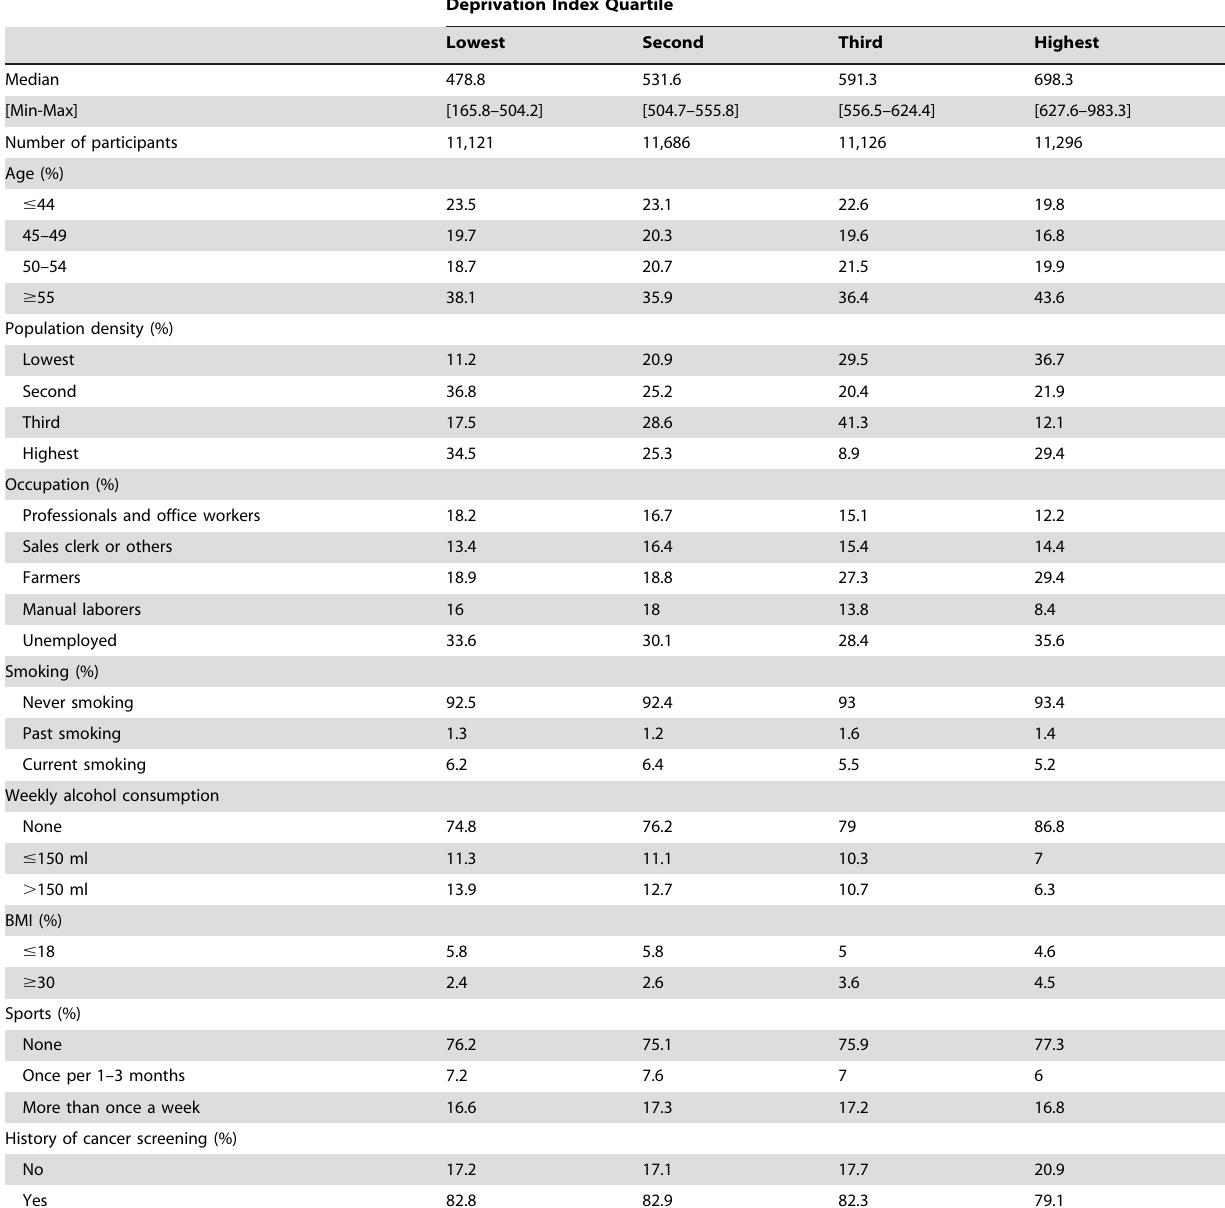
Table 2. Baseline characteristics in women